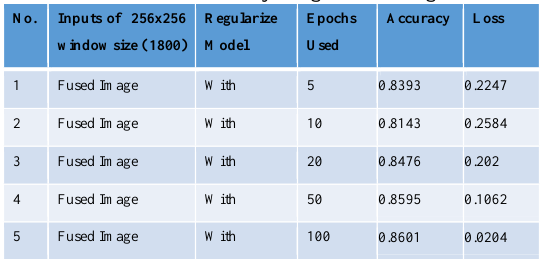
Table 5 . Fused Image Window Size (256 X 256) Used for the Training of